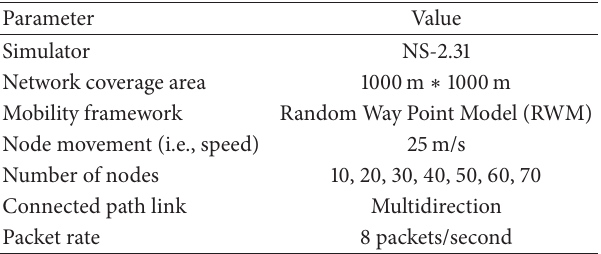
Table 1: Simulation parameters. Table 2: Energy consumption comparison of each type of mobile nodes in WBAN using GTSSE, SWS-HM, and BGKM.